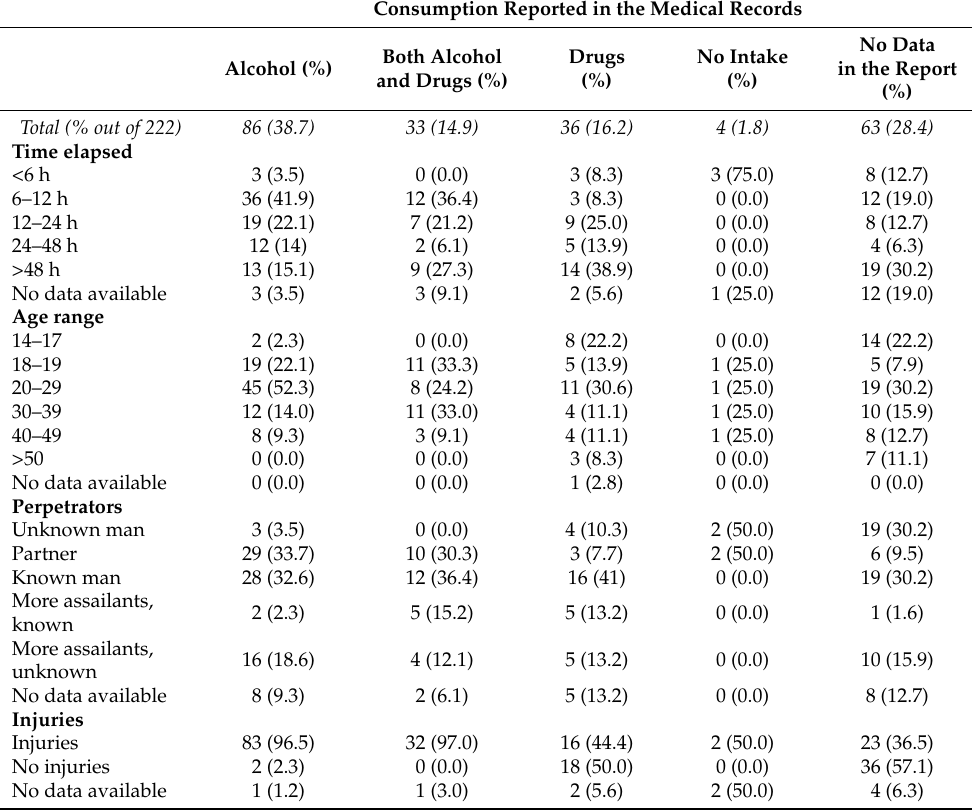
Table 2. Consumption of substances in relation to the time elapsed from rape, the age of the woman, the type of aggressor and the presence of